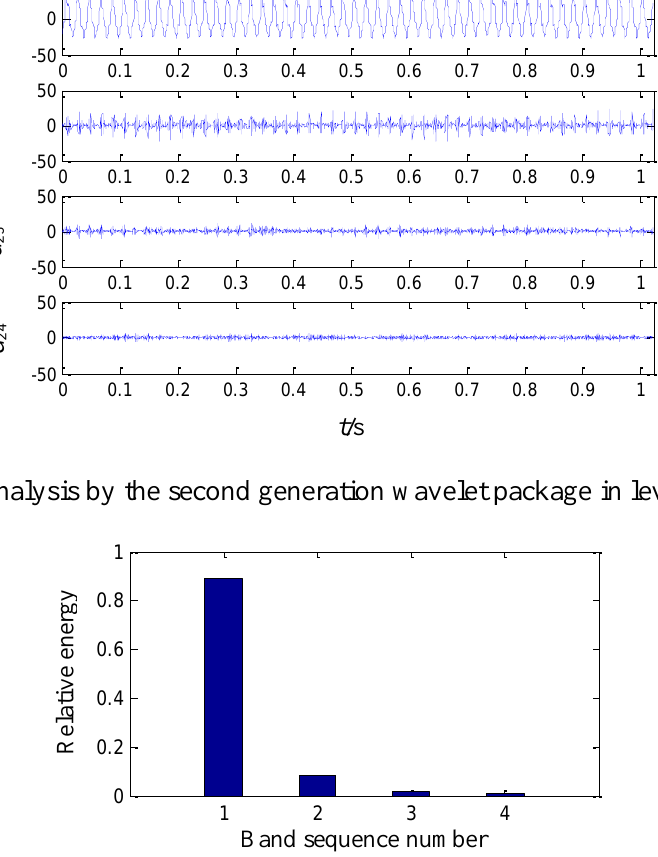
Figure 16. The sensor-dependent signal’s relative energy distribution after maintenance.